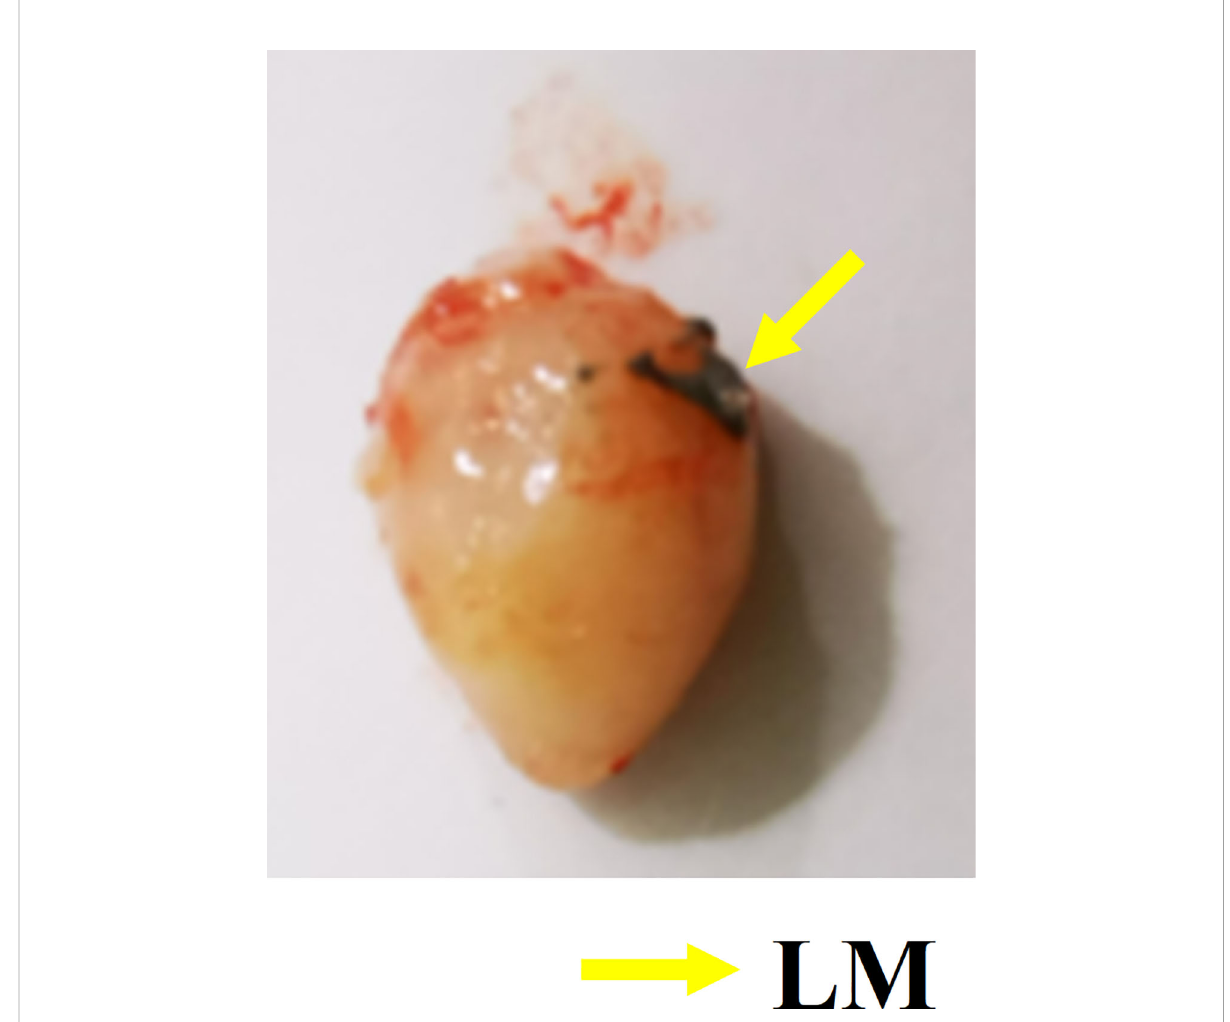
FIGURE 4 Gross specimen of tumor. The yellow arrow indicates the oxidized LM remaining on the tumor surface. LM, liquid